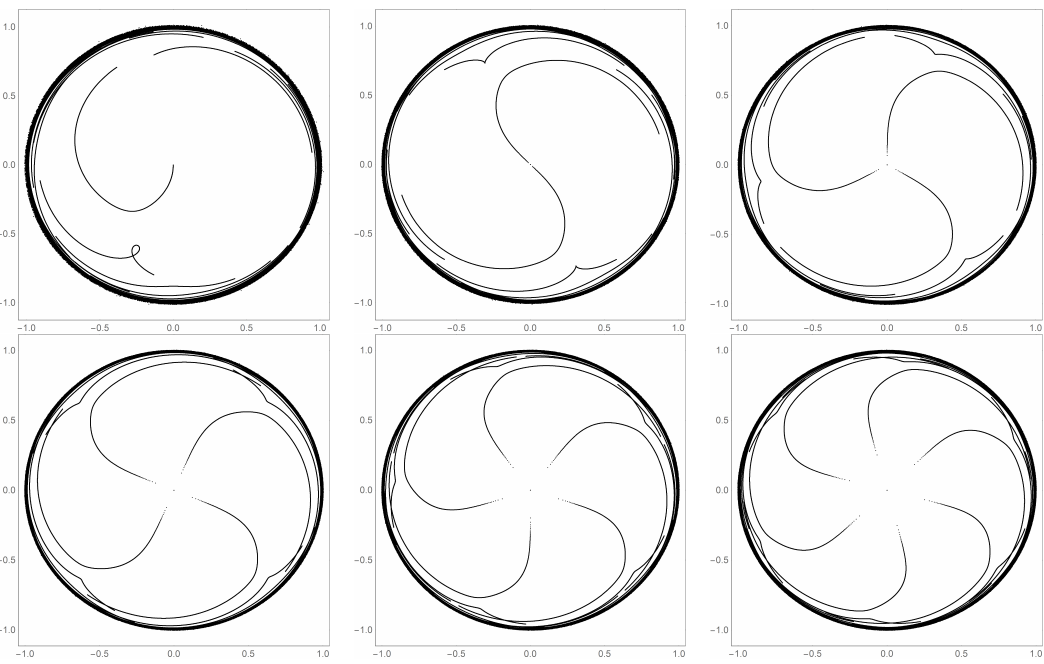
Figure 12. The movement of the fixed points as θ runs from 0 ◦ to 90 ◦ for k values 1–6, N = 20. The points originating close to the center are the primary fixed points, whereas the points very close to the unit circle are the secondary fixed